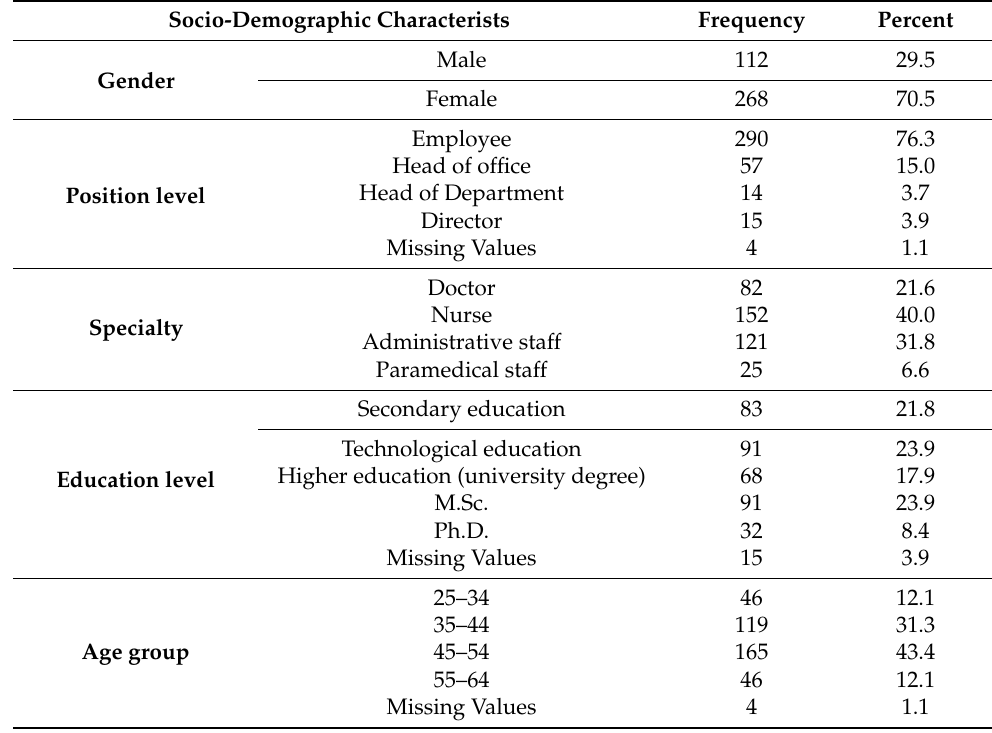
Table 2. Sampling frame description.